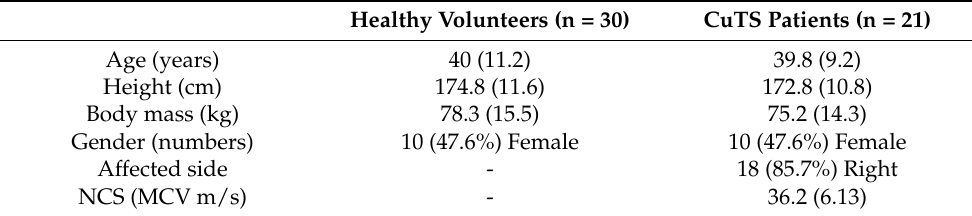
Table 1. Descriptive statistics, mean value